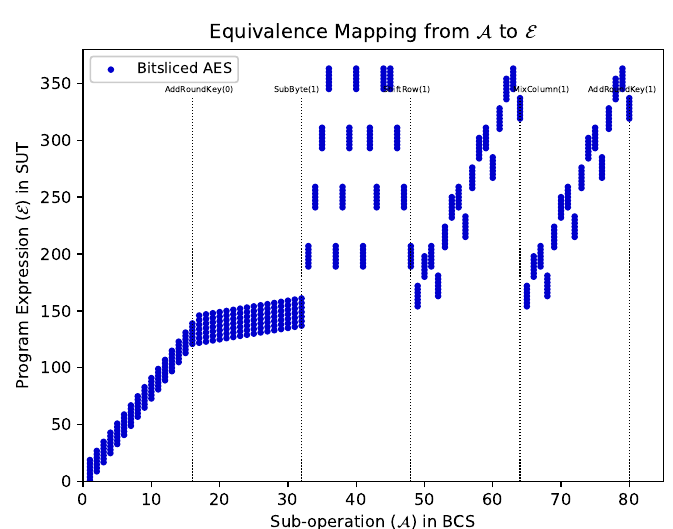
Figure 10: Equivalence Mapping output for a single round of the bitsliced AES implemen- tations ( IMP7 ) given in Table 2. The x-axis denotes the sub-operations in BCS and y-axis is the corresponding program expression in